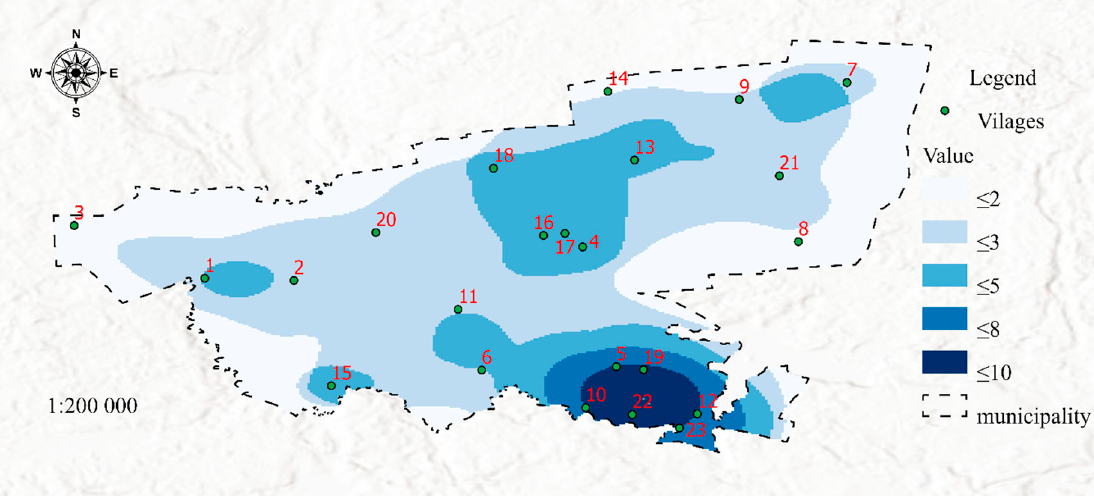
Figure 7. Map 5-Visualization of aging areas (dataset 5). Source: Own study.